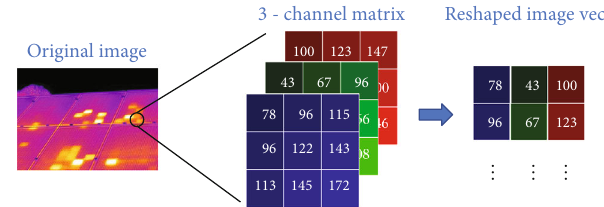
Figure 7: Converting Image to Vector.